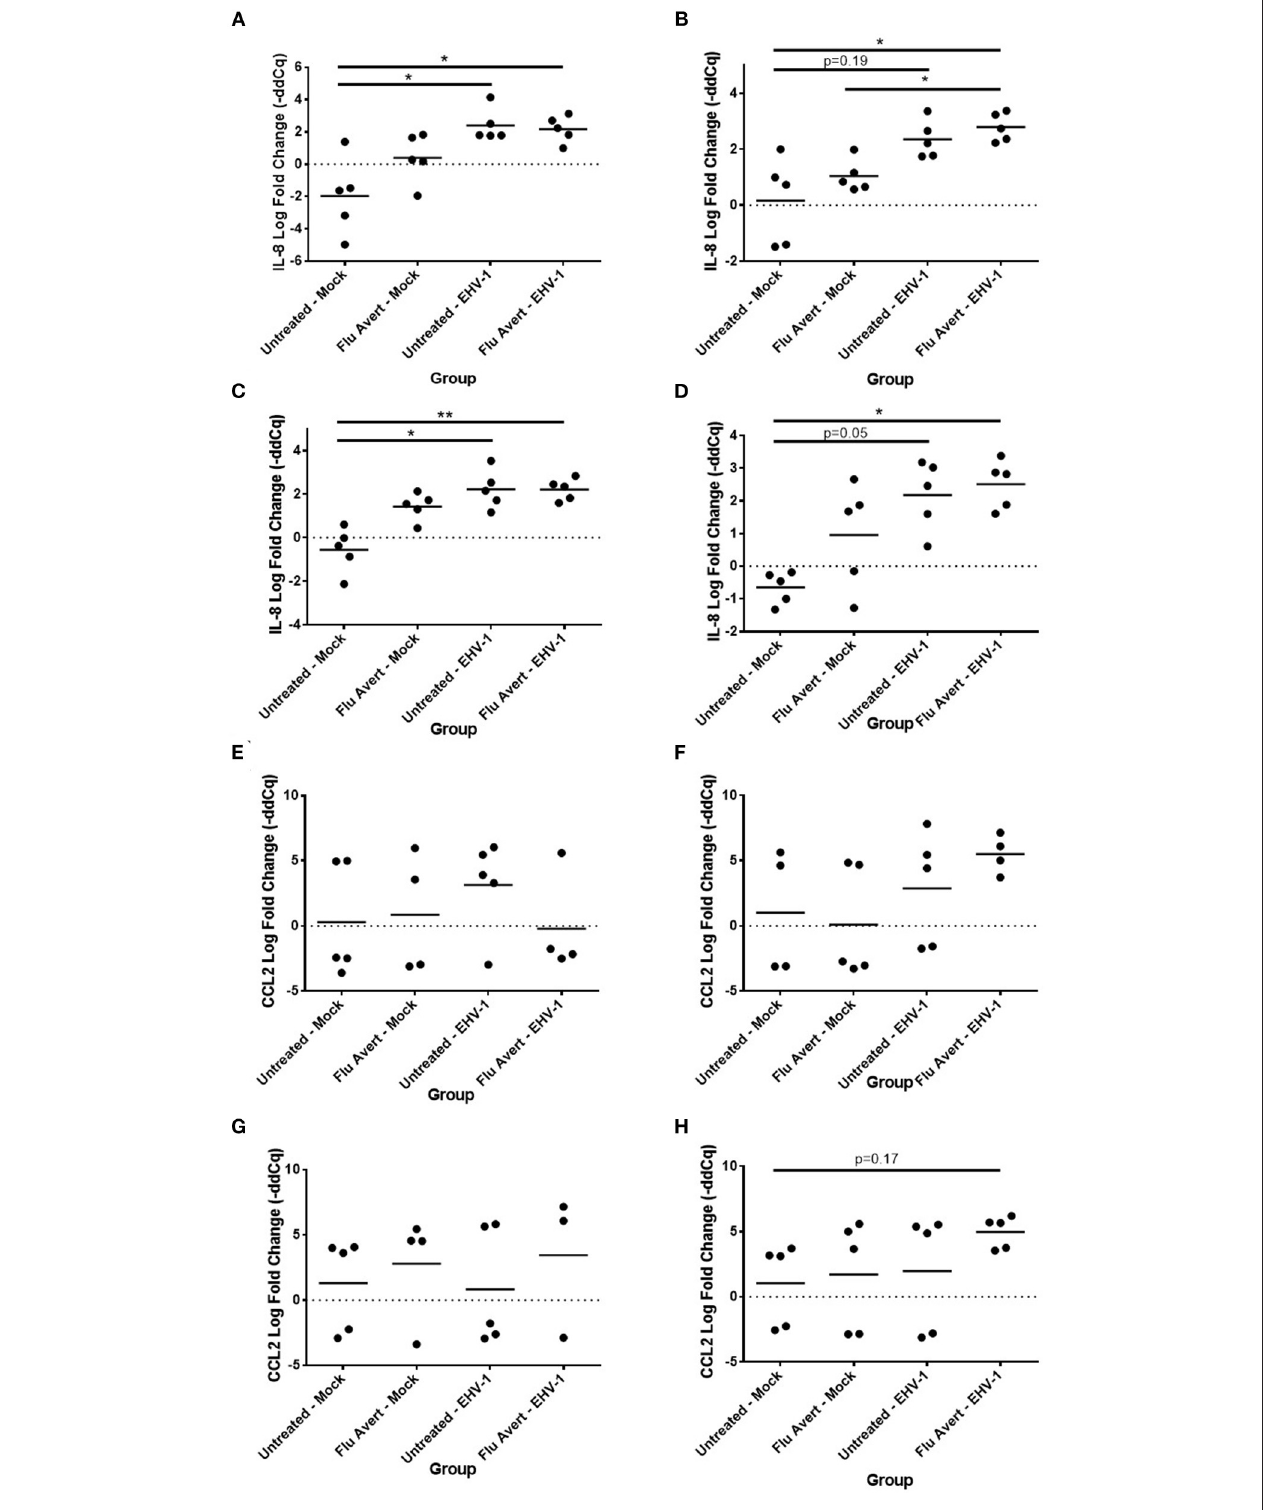
FIGURE 5 | Effect of Flu Avert treatment on chemokine mRNA expression in ERECs collected from five horses 48h following EHV-1 inoculation. (A) IL-8 mRNA expression in ERECs that were treated with Flu Avert on day 1 prior to EHV-1 inoculation. (B) IL-8 mRNA expression in ERECs that were treated with Flu Avert on